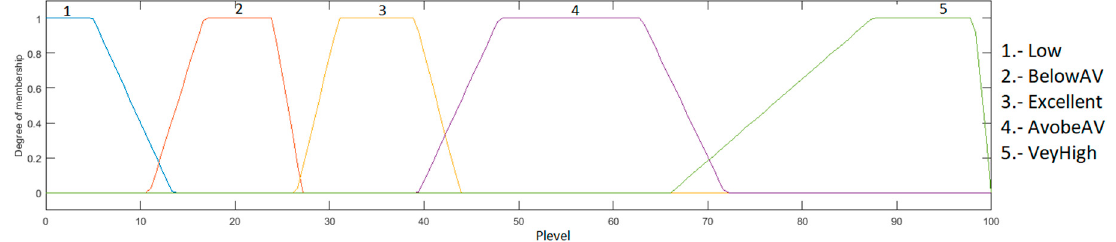
Figure 20. Optimized input heart rate.